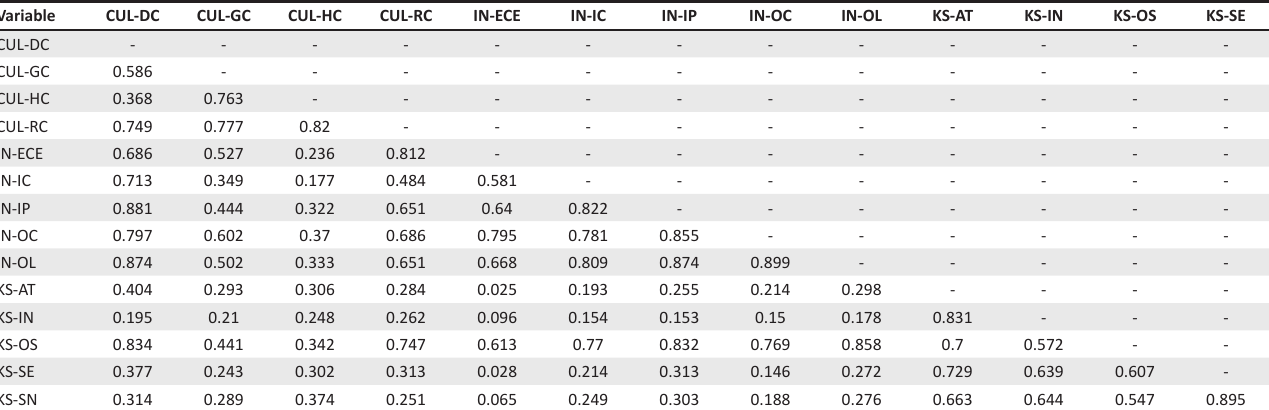
TABLE 3: Heterotrait-monotrait ratio ratios. Variable CUL-DC